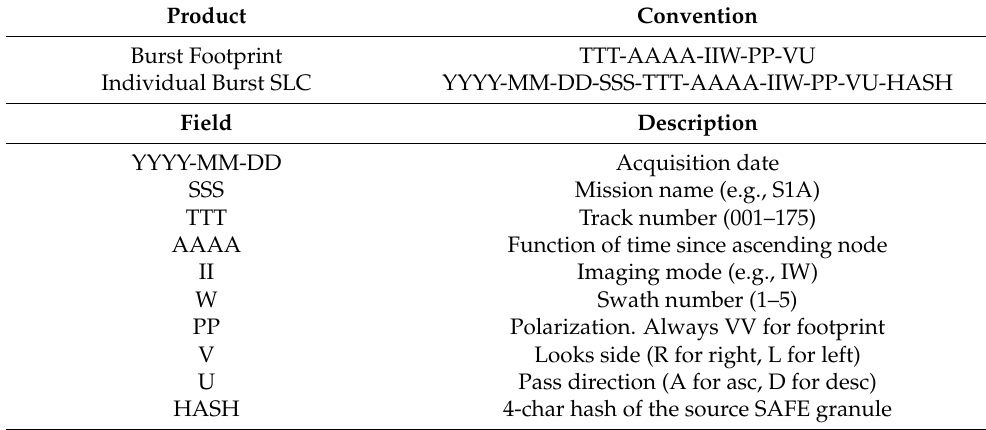
Table 1. Naming convention for Sentinel-1 burst footprints and individual